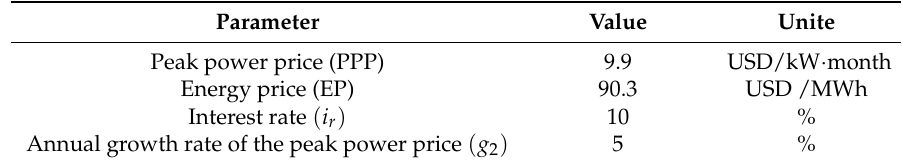
Table 3. Economical parameters.